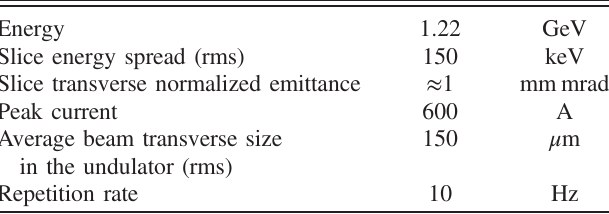
TABLE II. Seed-laser parameters used in this work for the two possible modes of operation (THG and OPA).